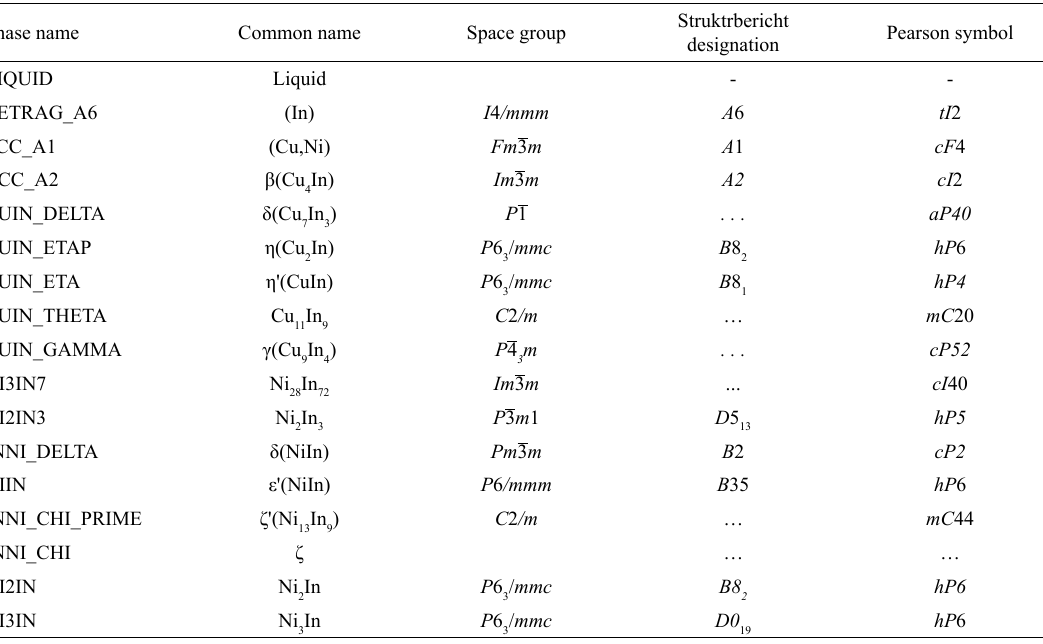
Table 1. Considered phases in Cu-In-Ni ternary system and their crystal structures